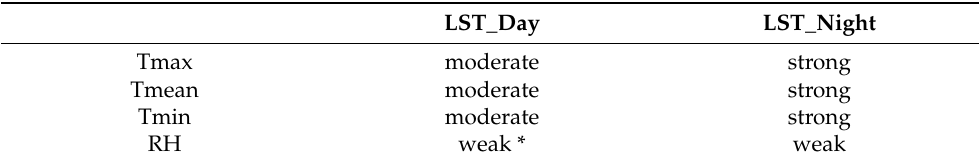
Table 12. Corresponding interpretation of the quantitative values from the correlation analysis [45]. (* not significant).